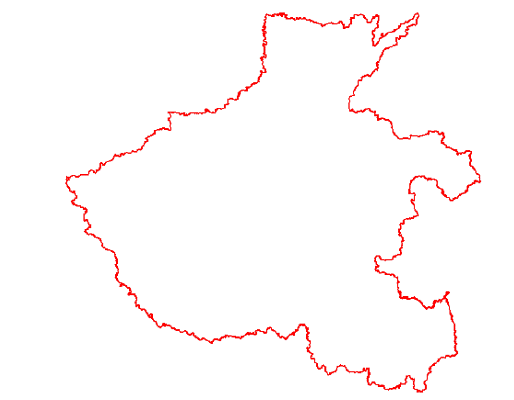
Figure 7. Sketch chart of the overall effect in the cube